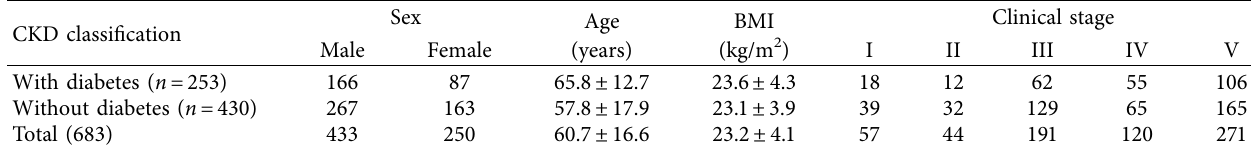
Figure 1: Research flowchart. Table 1: General data of CKD patients with or without diabetes ( x ± s ( n